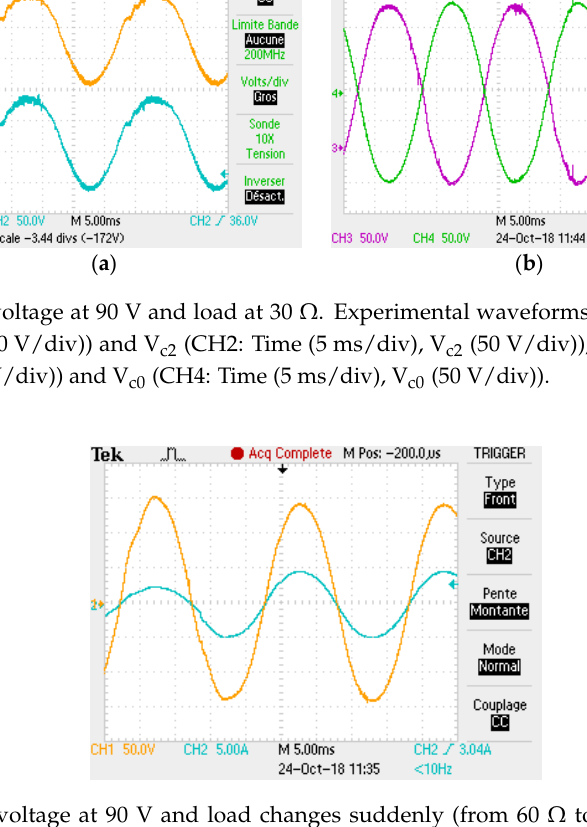
v (50 V/div)) and I (CH2: Time (5 ms/div), o o